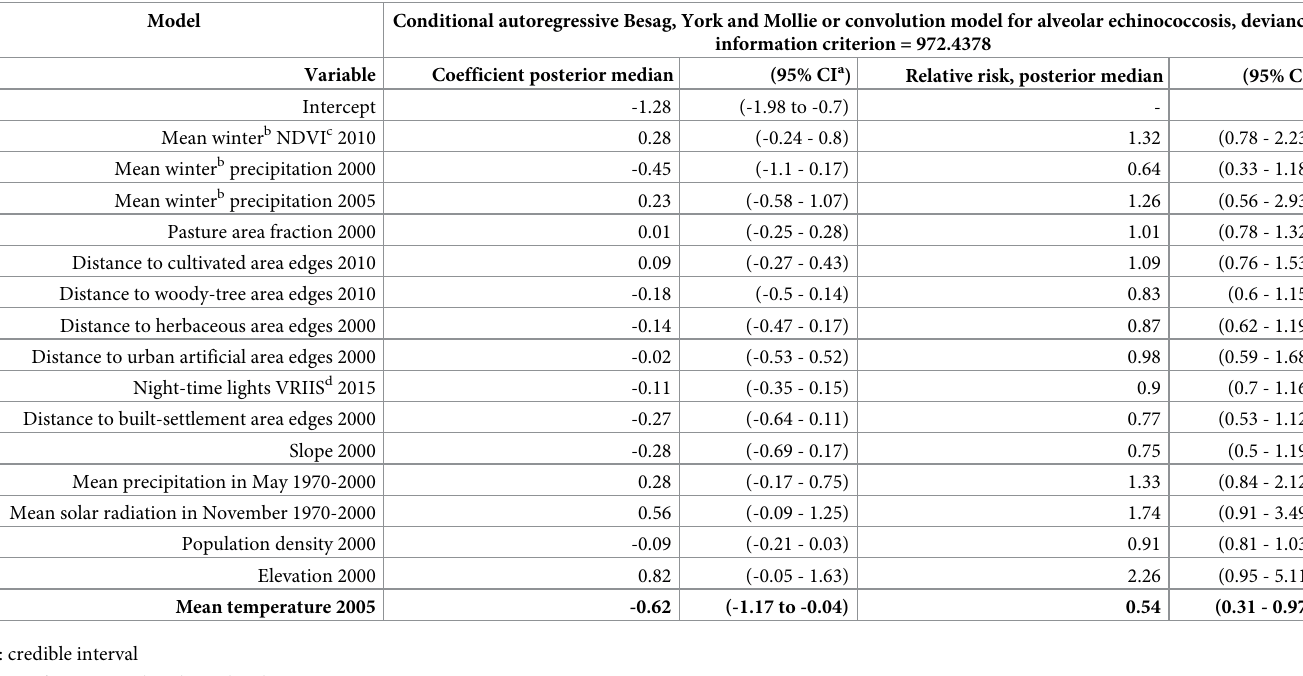
Table 4. Variables, regression coefficients (posterior medians), relative risk, 95% credible intervals from conditional autoregressive Besag, York and Mollie´ or con- volution model for alveolar echinococcosis in Kyrgyzstan, 2014-2016.